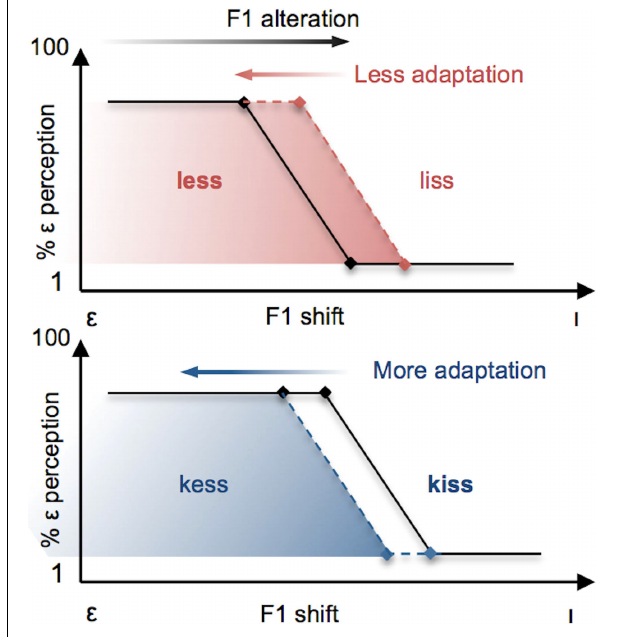
FIGURE 3 | Schematic illustration of the effects predicted in the present study. Vowels are altered by a change in F1 frequency, resulting in [ ε ] productions being perceived more like [ı] (black arrow at top). The resulting compensatory change in speech output (red and blue arrows) has the effect of restoring the subject’s perception of their vowel to the original vowel category [ ε ]. Top Panel : F1 vowel alterations that have the effect of changing the lexical status of a real word (e.g., less ) to a pseudo-word (e.g ., liss ) are predicted to yield reduced compensatory changes in participants’ productions (red arrow) as a result of the perceptual lexical effect, whereby the boundary for the vowel contrast is shifted in the direction of [ı] (red dashed line). Bottom panel : When the same F1 vowel alteration has the effect of changing the lexical status of a pseudo-word to a real-word, a larger compensatory change is expected (blue arrow) due to the perceptual boundary shifting in the direction of the vowel [ ε ] (blue dashed